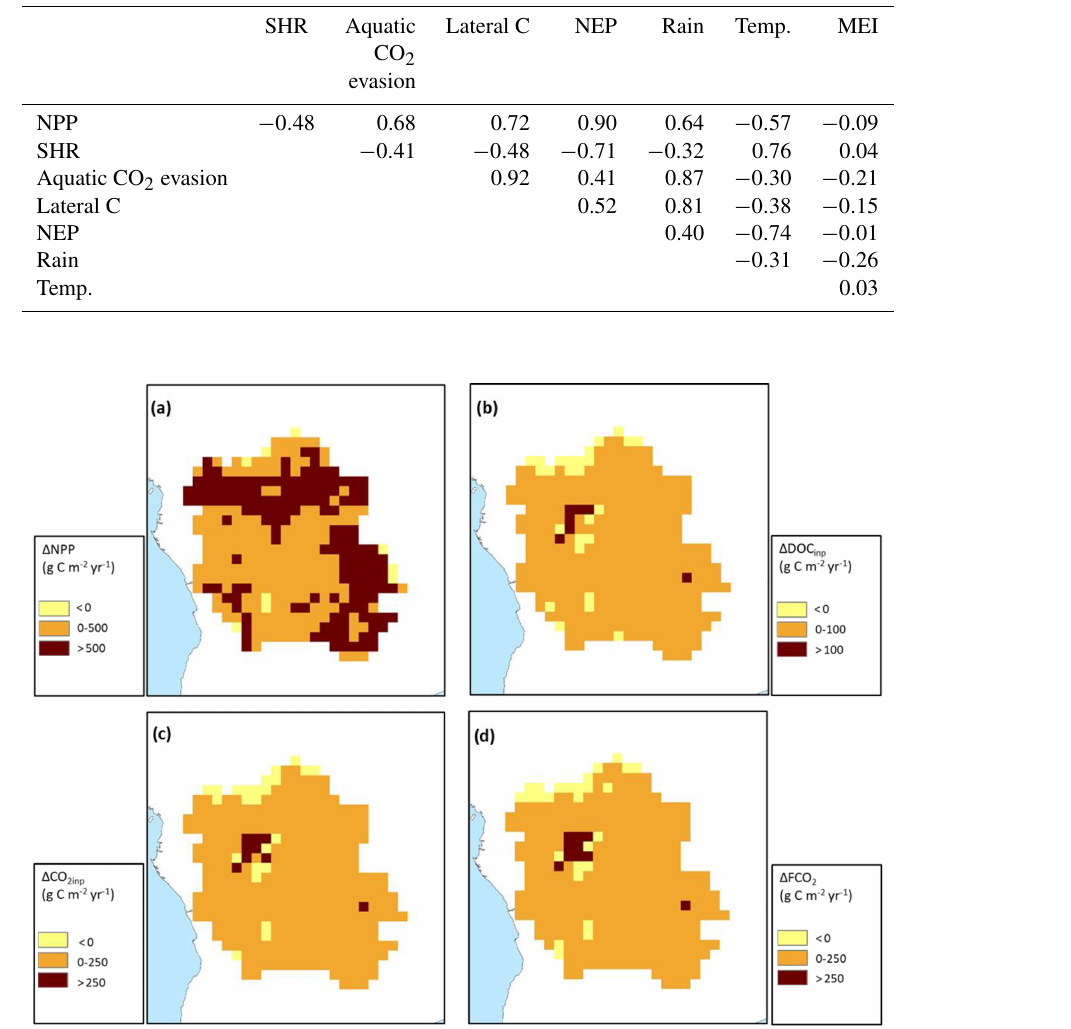
Table A2. Pearson correlation coefficient ( r ) between detrended carbon fluxes and detrended climate variables.